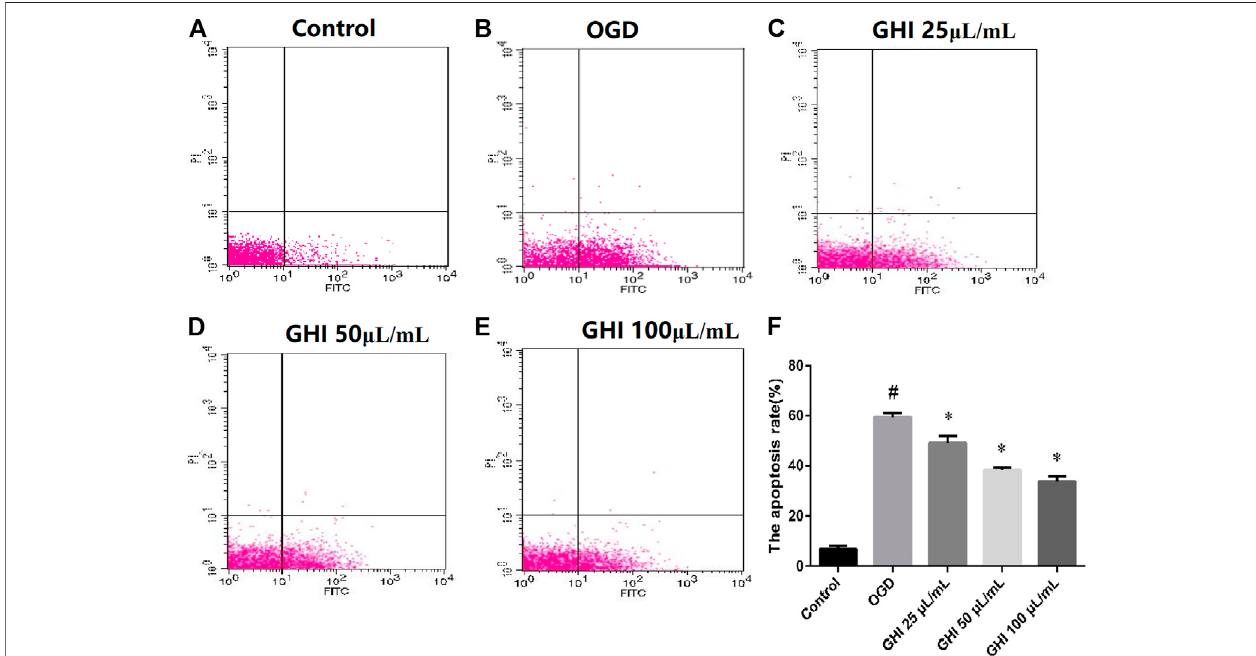
FIGURE 10 | Effects of GHI on apoptosis rates of rBMECs in OGD injury. Values were expressed as the means ± SD (n (cid:2) 3). (A – E) Flow cytometry images and (F) statistical analysis of the apoptosis rate. # p < 0.01 compared with the control group; * p < 0.01 compared with the OGD group.